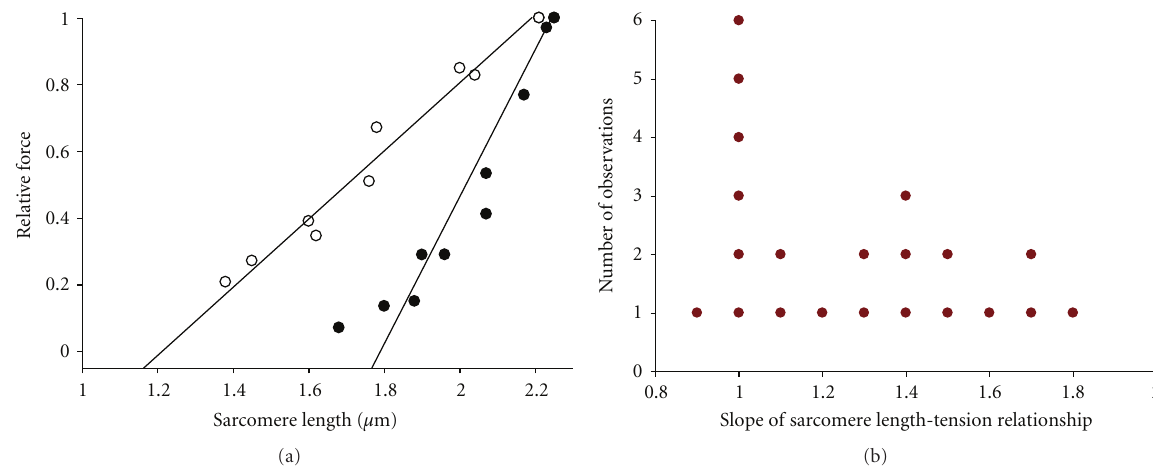
Figure 1: Sarcomere length-tension relationships in porcine skinned ventricular cardiac myocyte preparations. (a) Muscle cell preparations were mounted between a force transducer and motor, calcium activated to yield ∼ 50% maximal force, then isometric force was measured over a range of sarcomere lengths monitored using an IonOptix SarLen system. (b) Histogram showing the slopes of length-tension relation- ships obtained in porcine cardiac